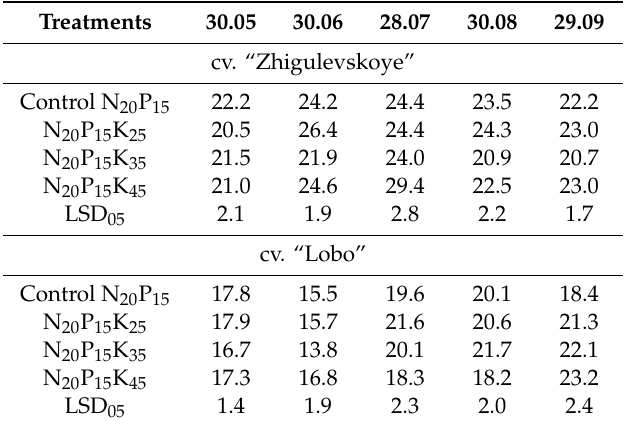
Table 9. Seasonal variations of the exchangeable soil calcium content in the experimental plots of di ff erent cultivars in 2016, Mmol 100 g − 1